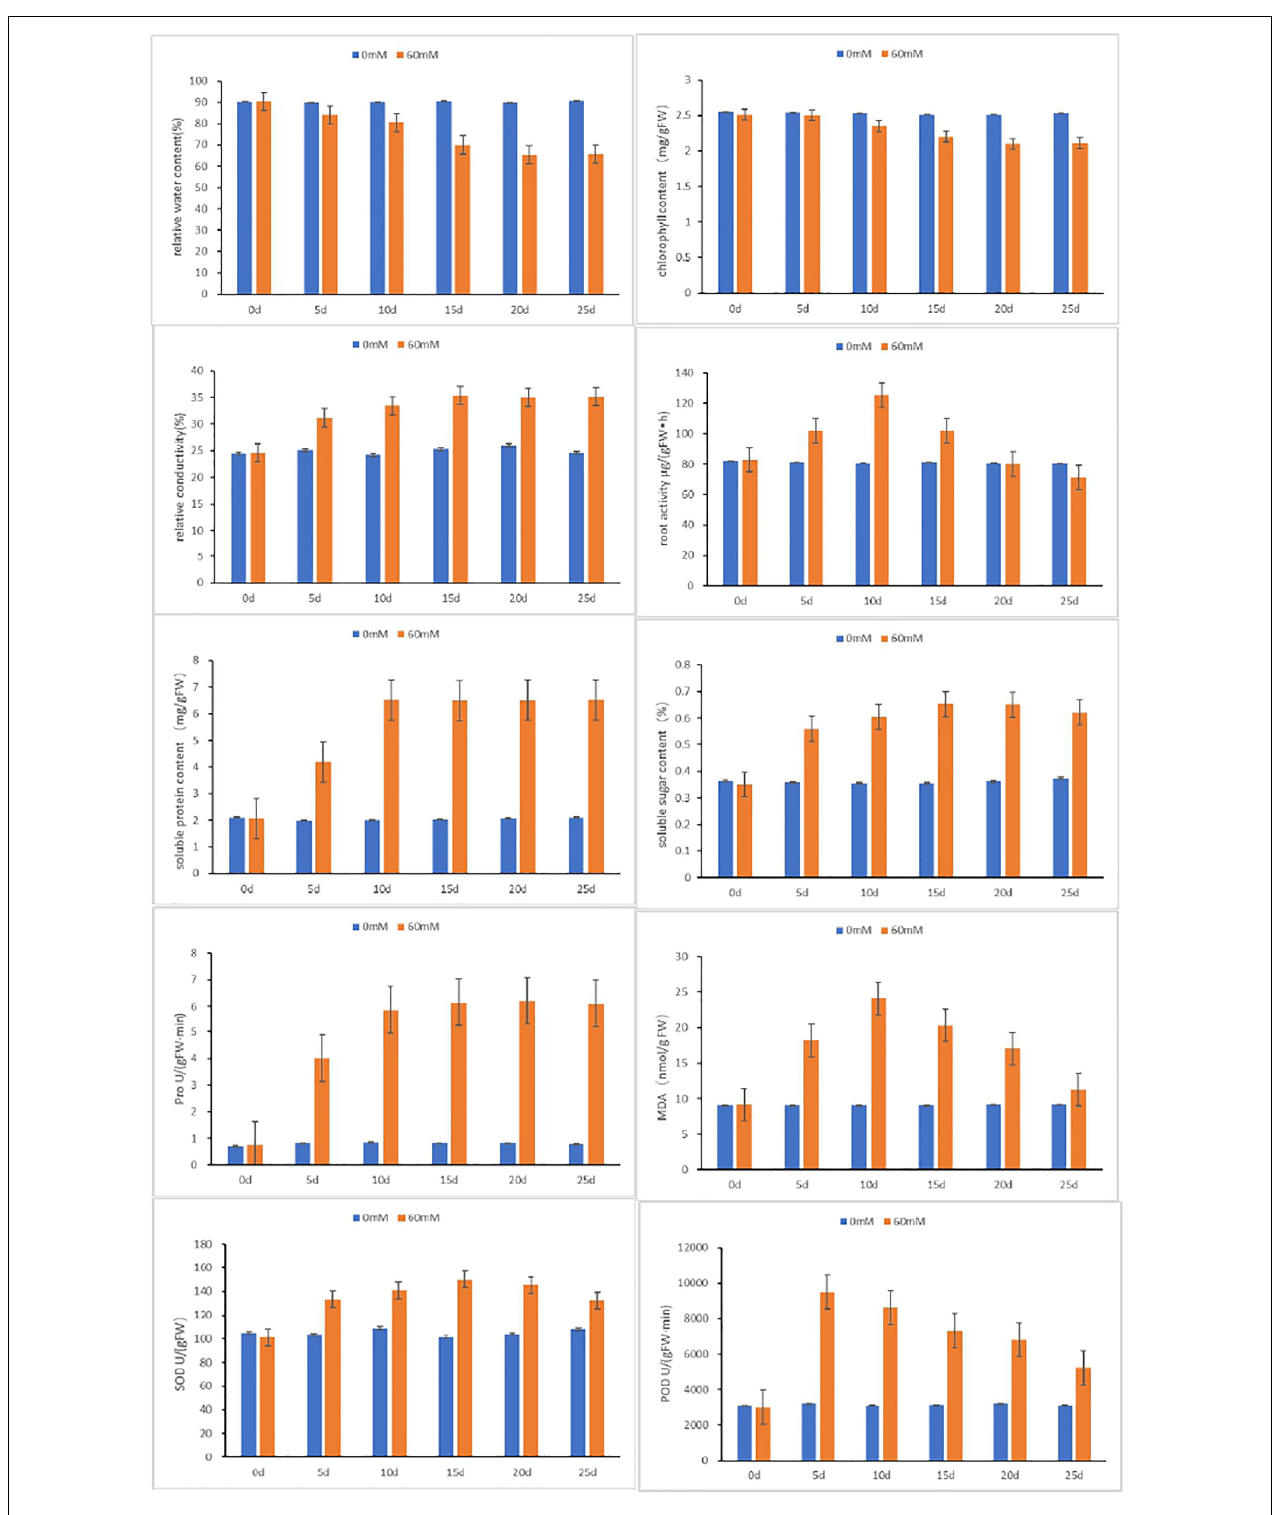
FIGURE 2 | Physiological analyses of BD in response to salt stresses at 0, 5, 10, 15, and 20 days after treatments. Relative water content, chlorophyll content, relative conductivity, root activity, Pro, soluble sugar content, soluble protein content, MDA, S OD and POD were examined under normal and treated conditions. Data are means ± SD calculated from three independent